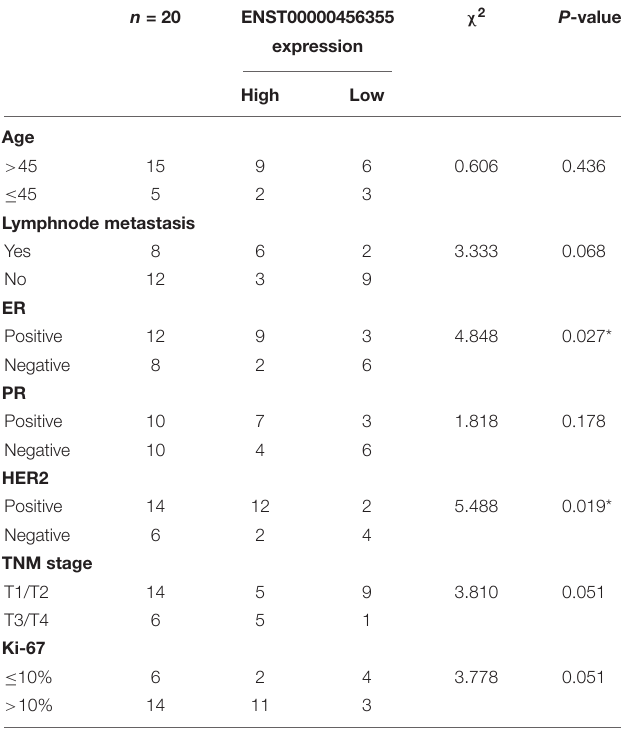
TABLE 2 | Association between ENST00000456355 and clinicopathological characteristics of patients with breast cancer ( n = 20). n =